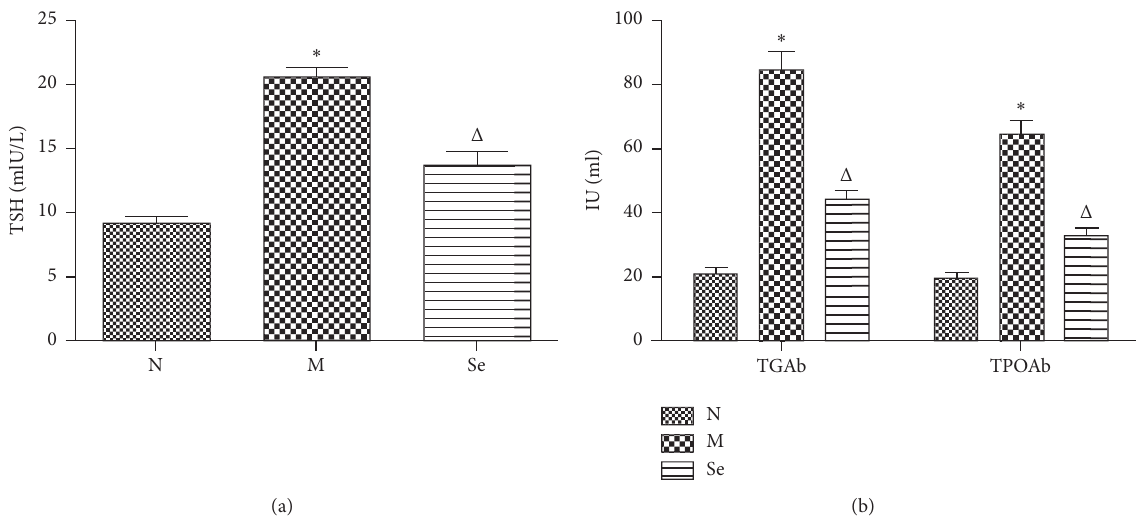
Figure 1: (a) Serum TSH titers in each group rats. (b) Serum TGAb and TPOAb titers in each group rats. N, normal control; M, EATmodel group; Se, selenium yeast supplement EAT group. ∗ P < 0 . 05 compared to the N group. △ P < 0 . 05 compared to the M group.